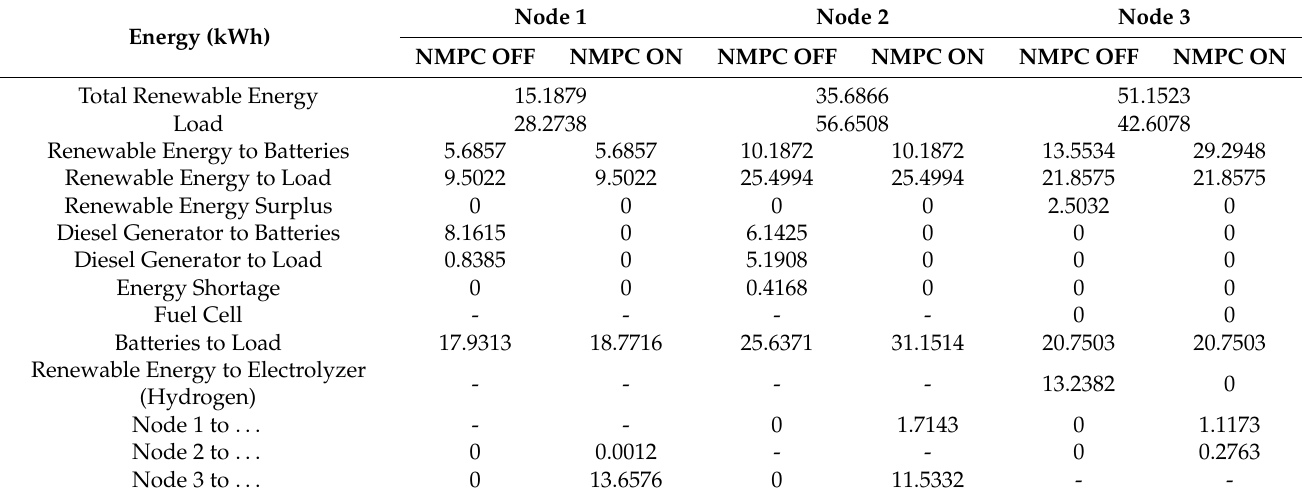
Table A1. Comparative results from Scenario 1 — Daily operation.